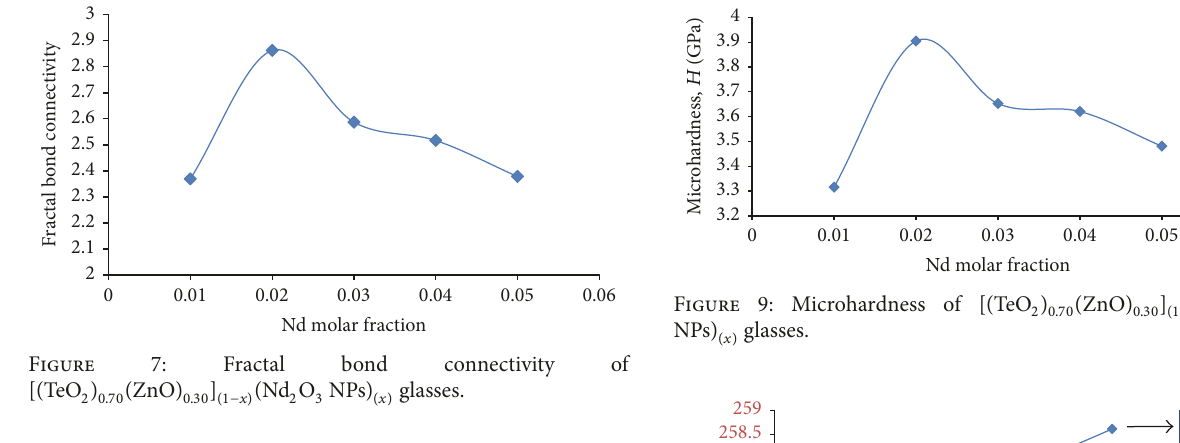
0.2050.210.2150.220.2250.230.2350.240.2450.250.255